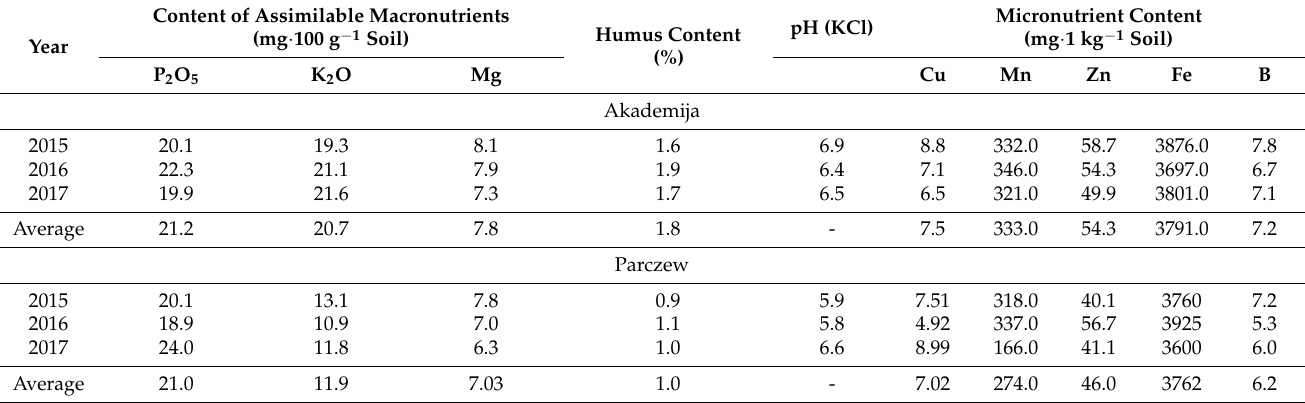
Table 1. Physical and chemical properties of soils in Akademija and Parczew (2015–2017). Content of Assimilable Macronutrients (mg · 100 g − 1 Year